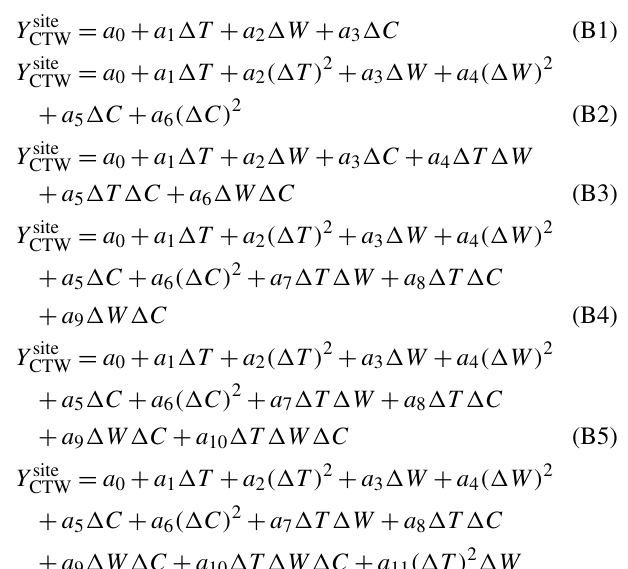
a “IRR” indicates irrigated, “RFD” indicates rain-fed, “mid” indicates midlatitudes (30–70 ◦ S, 30–70 ◦ N), “tropic” indicates 30 ◦ S to 30 ◦ N. b Note that the mean response function has “excellent” performance for all production groups.